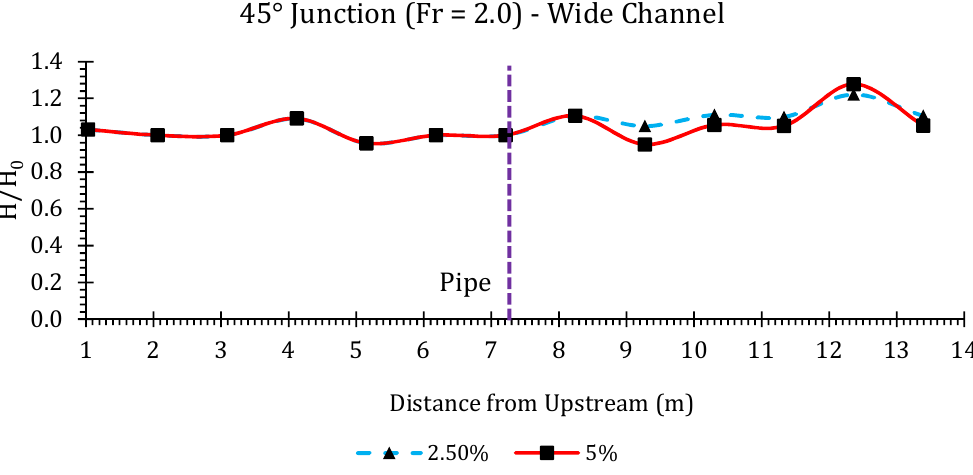
Figure A14. Water height ratios in a 45 ◦ junction for Fr = 2.0 in the wide Figure A14. Water height ratios in a 45° junction for Fr = 2.0 in the wide channel. Figure A14. Water height ratios in a 45° junction for Fr = 2.0 in the wide channel. Figure A14. Water height ratios in a 45° junction for Fr = 2.0 in the wide channel.